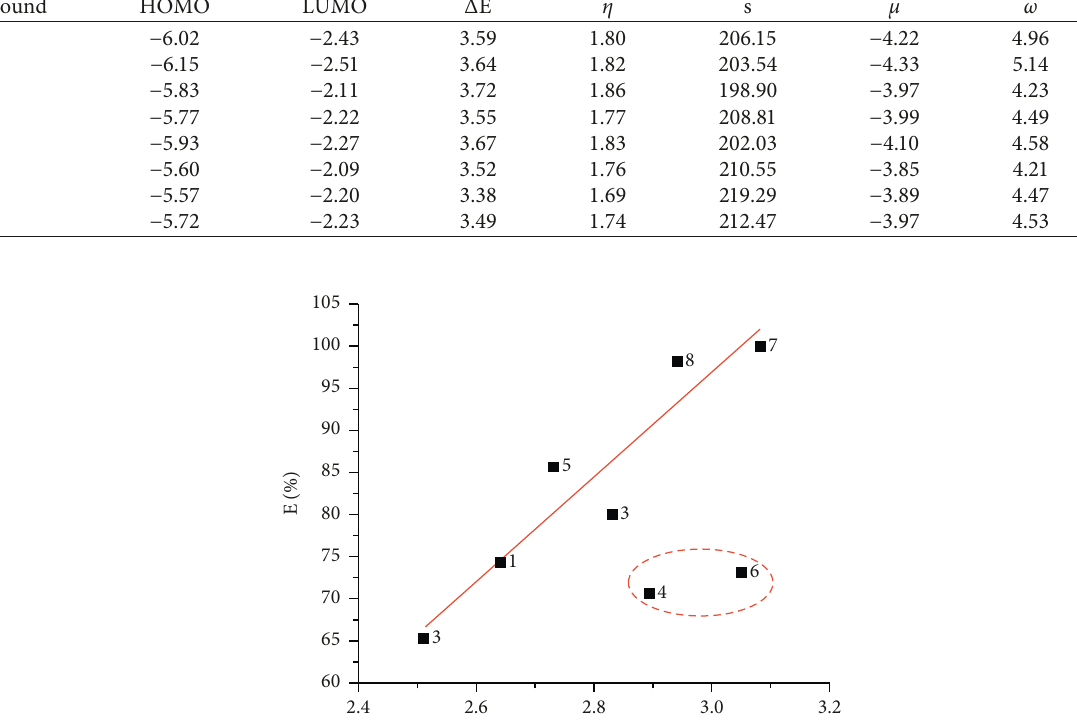
Table 4: HOMO and LUMO energy, energy gap Δ E, and global reactivity indices μ , ω , η , and N (eV) for curcumins 1–8 . Compound HOMO